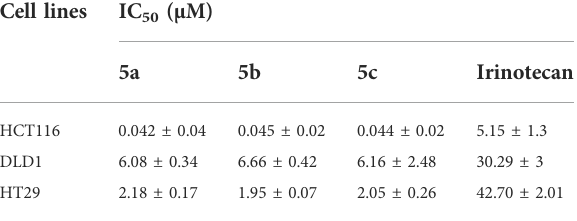
TABLE 2 Antiproliferative activity of compounds 5a, 5b, and 5c.